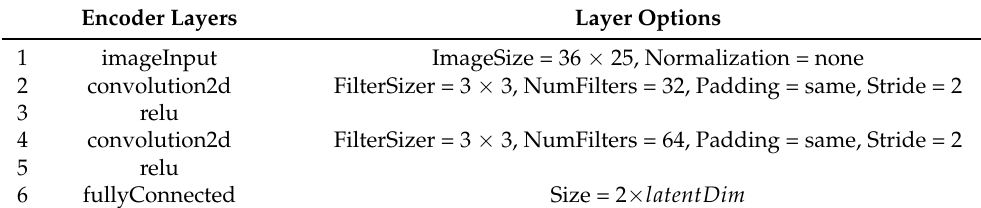
Table 3. Decoder architecture.